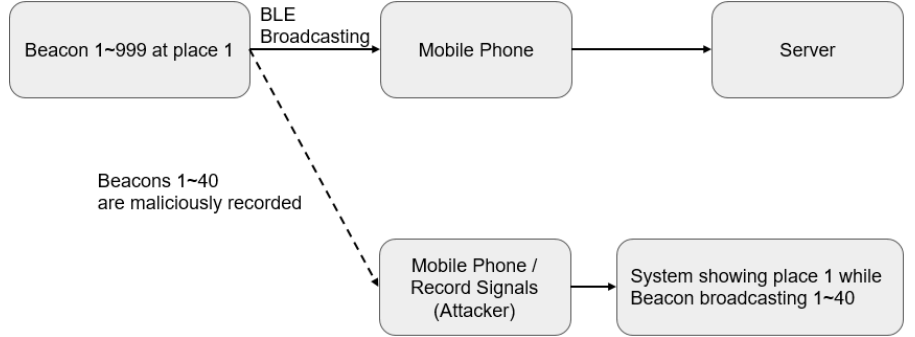
Figure 11. Recording and limited reproduction.